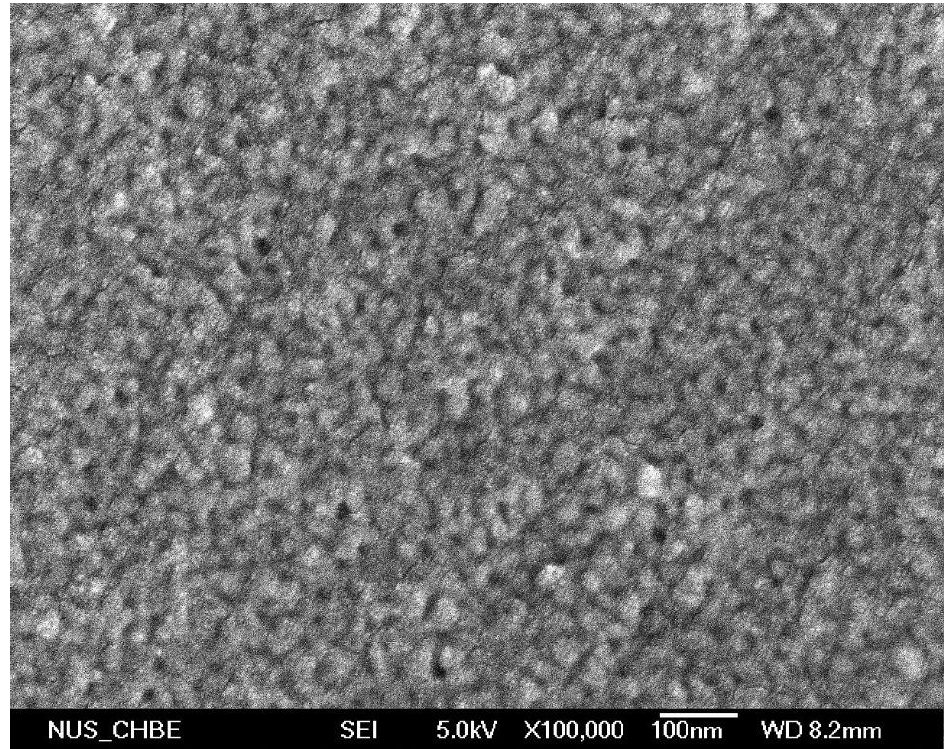
Figure A3. FE-SEM images of cross-linked diblock A100G4S-10 membrane (magnification 50,000×).